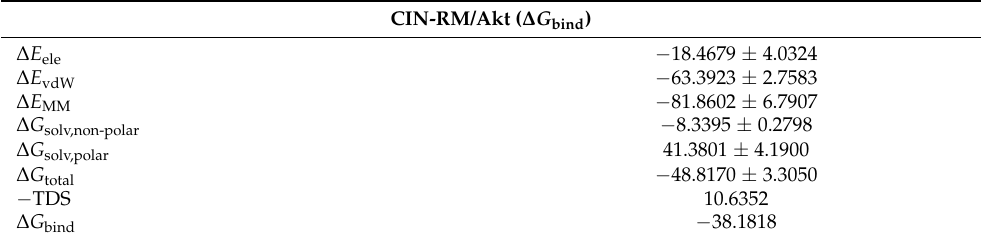
Figure 7. Docked model depicting the interaction of CIN-RM with the Akt protein. ( a ) Binding mode and docking energy of CIN-RM bound to the binding site of Akt taken from the MD study. ( b ) 2-dimensional (2D) of the interaction detail between CIN-RM and Akt. ( c ) The RMSD plot for the interaction of the CIN-RM/Akt complex during 300 ns of molecular dynamic simulation. ( d ) Total energy decomposition of the CIN-RM/Akt complex using the gmx_MMPBSA program. Table 1. The MM/GBSA ( ∆ G bind ) and its energy components (kcal/mol) of the CIN-RM/Akt